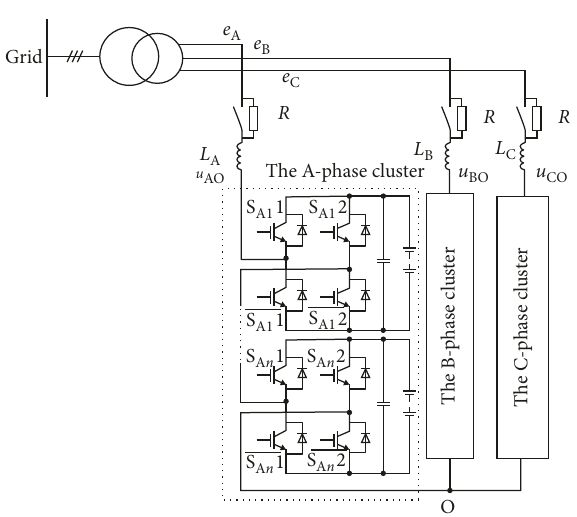
Figure 1: Circuit of the cascaded H-bridge